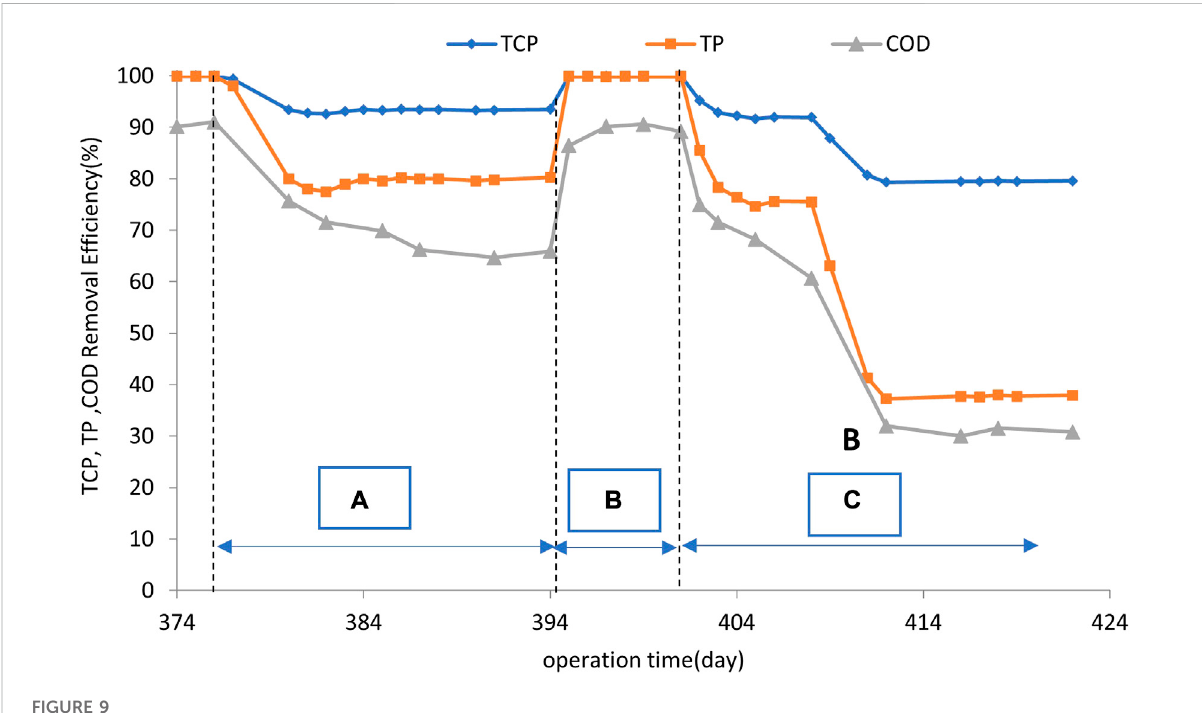
FIGURE 9 The effect of RBB on the